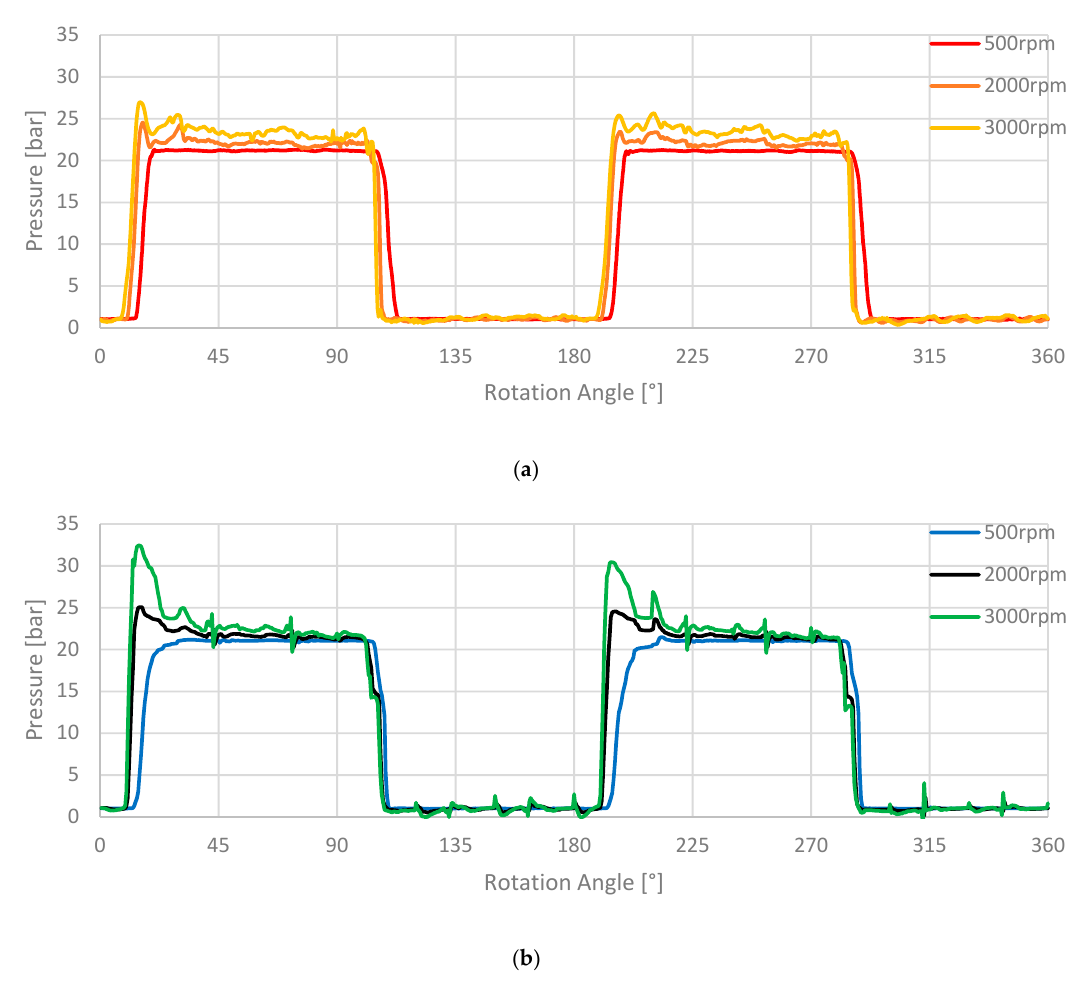
Figure 14. Influence of rotational speed at a constant delivery pressure of 20 bar on the displacement chamber pressure ( a ) measurement; ( b ) simulation.